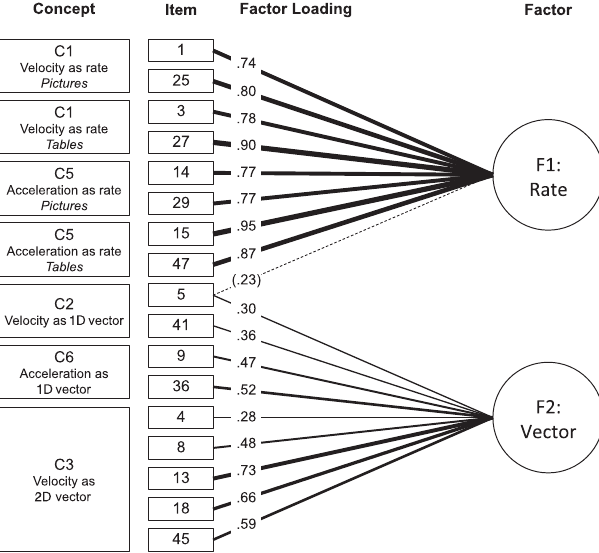
FIG. 4. Factor loadings of the picture and table items on two factors. The left side shows the assignment of the items to the corresponding concepts. The EFA was conducted with PAF. Again only loadings above 0.20 are shown in the figure. Loadings above 0.30 are considered to be significant. The solid lines mark the highest loadings on the individual items. Lower loadings are indicated with dotted